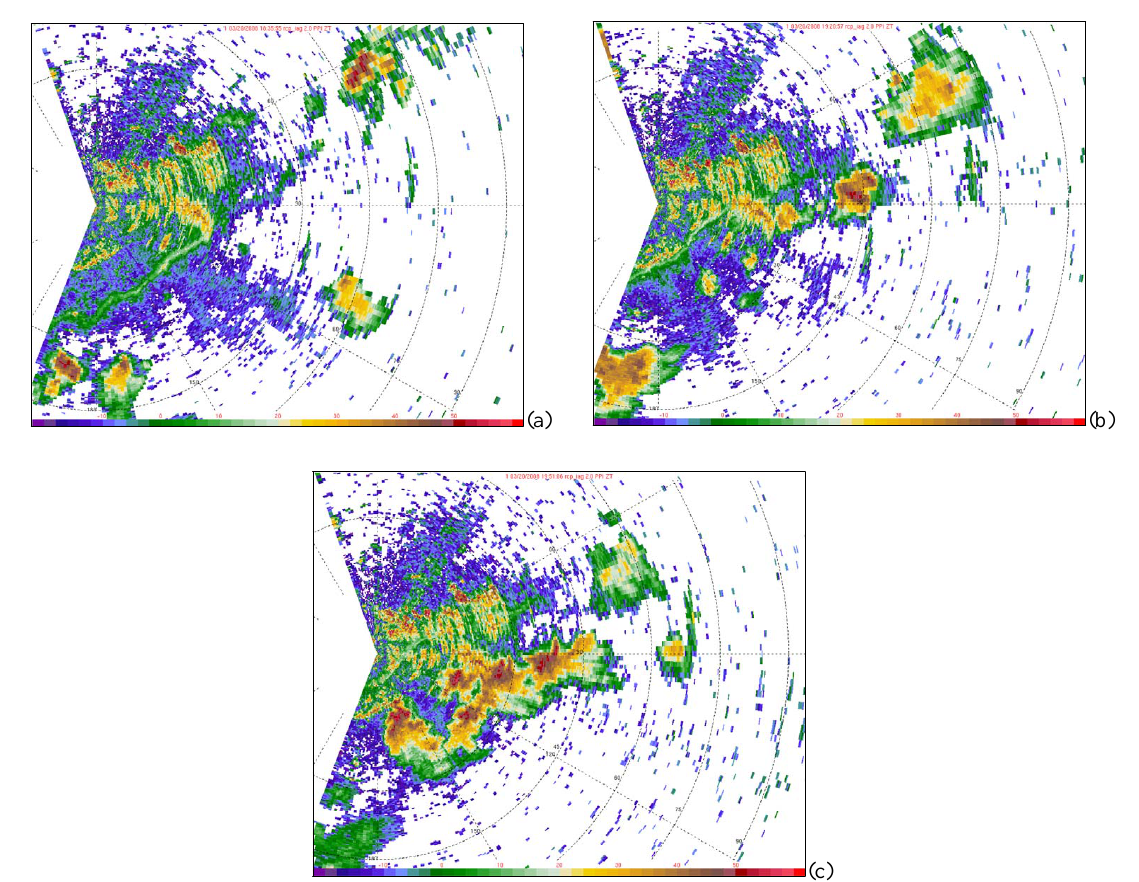
Fig. 8. 2 ◦ PPI of reflectivity ( Z – dBZ) at 18:35UTC (a) , 19:20UTC (b) and 1951 (c) obtained with MXPOL on 20 March 2008. Colour scale is